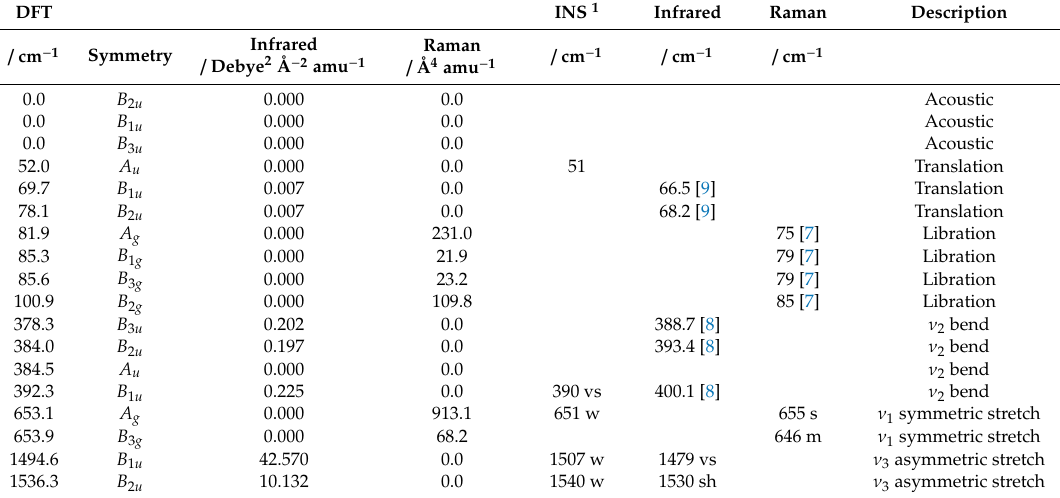
Figure 3. Vibrational spectra of solid CS 2 . (a) infrared at 208 K, (b) FT-Raman at ~ 77 K, (c) INS at 20 K, ×5 ordinate expansion, (d) INS at 20 K, and (e) INS spectrum generated from a periodic density functional theory (DFT) calculation of CS 2 . Table 1. Observed and calculated (at the Γ -point) transition energies and intensities of the fundamental modes of CS 2